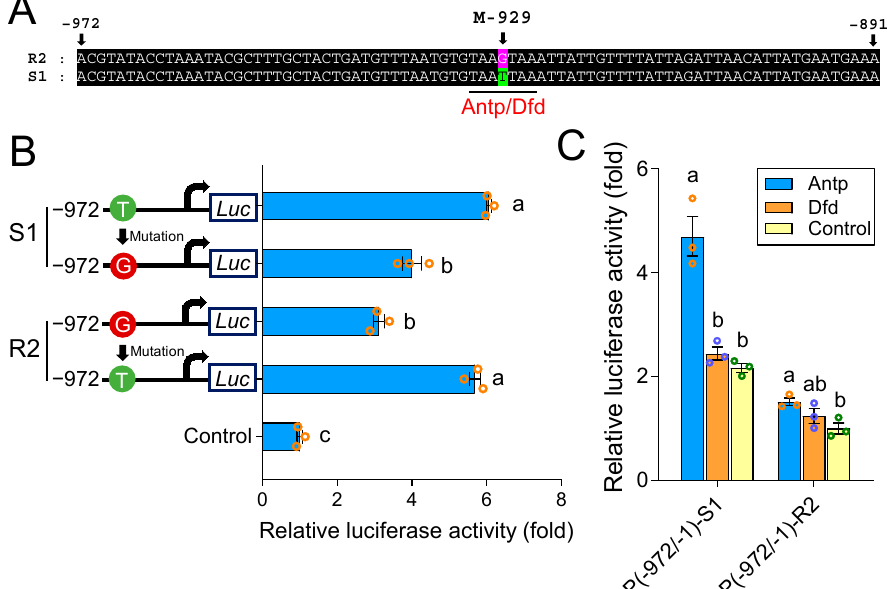
Figure 3. Analysis of the point mutation between − 972 and − 891. ( A ) Nucleotide sequence alignment of the fragment from − 972 and − 891 in PxABCG1 promoters S1 and R2. ( B ) Activity of the promoters P(-972/-1)-S1 and P(-972/-1)-R2 with site-directed mutagenesis at M-929. The empty pGL4.10 vector was used as a control. The significance of differences was determined by one-way ANOVA with Duncan’s test ( p < 0.05). Different letters on the bars indicate significant differences. ( C ) Effects of Antp and Dfd on the activity levels of PxABCG1 promoters S1 and R2. The empty pAc5.1 vector was used for controls. The significance of differences was determined by one-way ANOVA with Duncan’s test ( p < 0.05). Different letters on the bars indicate significant differences.